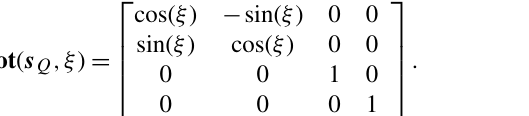
Figure 4. Coordinate